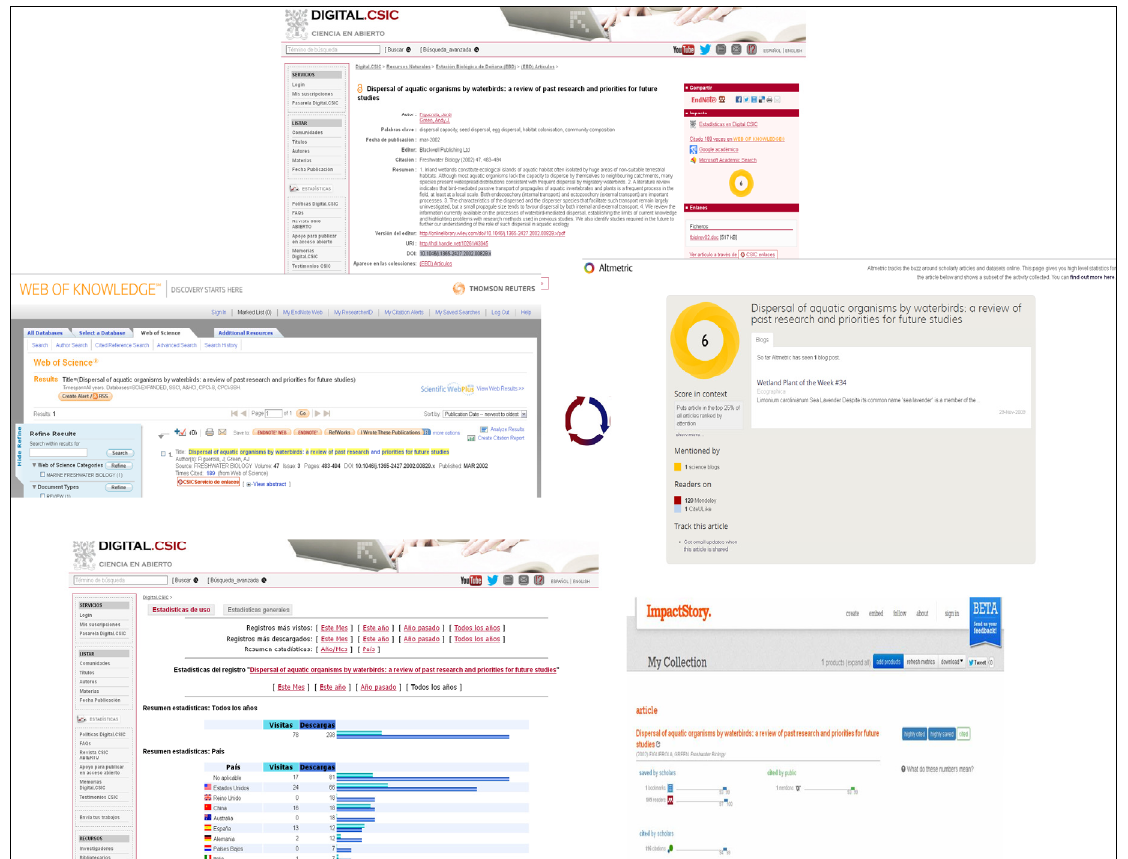
Figure 6. Impact data (immediate interest and medium term impact) collected for Dispersal of aquatic organisms by waterbirds: a review of past research and priorities for future studies